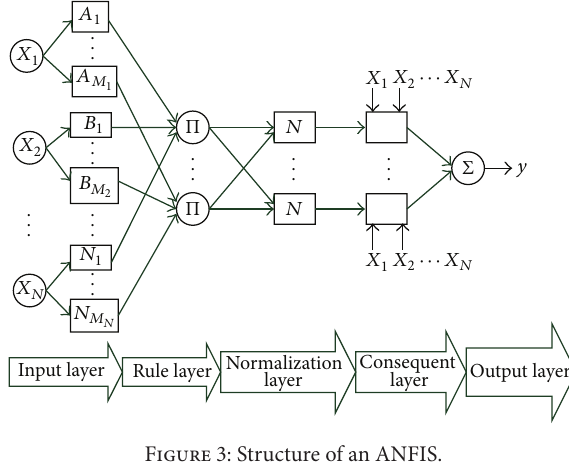
Figure 3: Structure of an